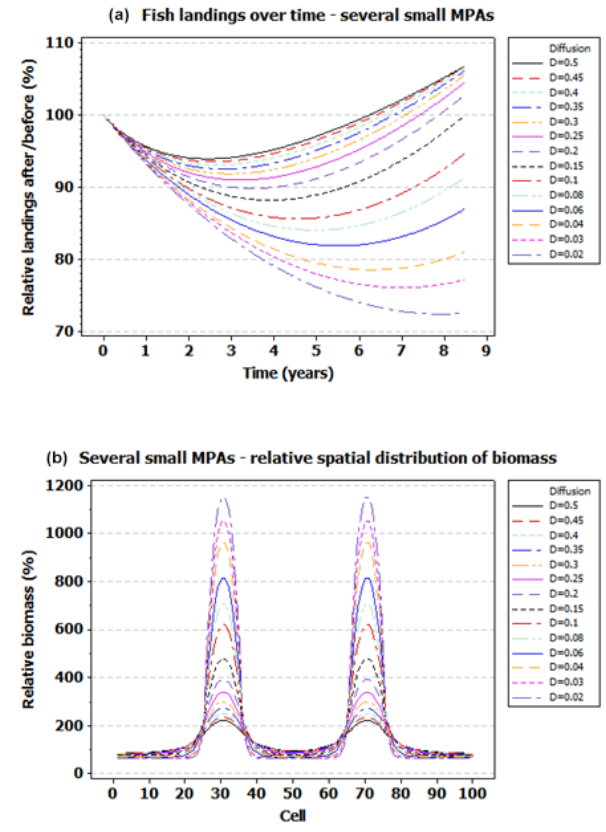
Figure 2. (a) Post-MPA establishment landings over time ( x axis) normalized by the landings before the establishment of two MPAs and replicated for a number of species’ dispersal potential (diffusion with values D ). (b) Post-MPA establishment spatial distribution of biomass normalized by the one prior to the MPA establishment. All results are referring to outputs at the end of simulation period (10th year). All simulation scenarios assume that 20% of cells are pro- tected with two equal-sized MPAs. All results presented here (re- garding fish biomass and annual catch) were normalized to 100 in the steady-state situation without the MPAs in each scenario, thus are unitless